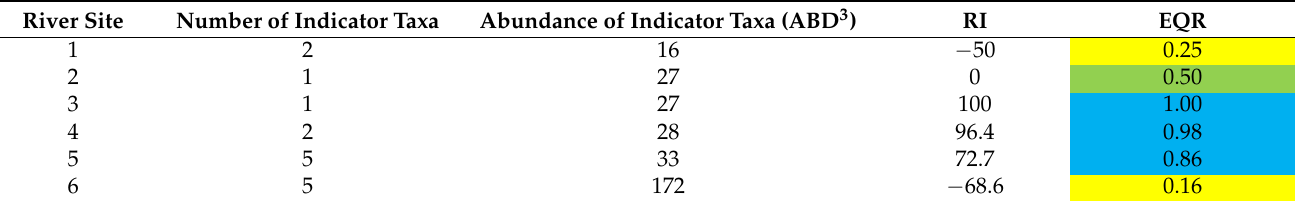
Table 3. Species richness, abundance, RI, and EQR. Legend: RI—Reference Index; EQR—Ecological Quality Ratio: blue—high, green—good, and yellow—moderate ecological status